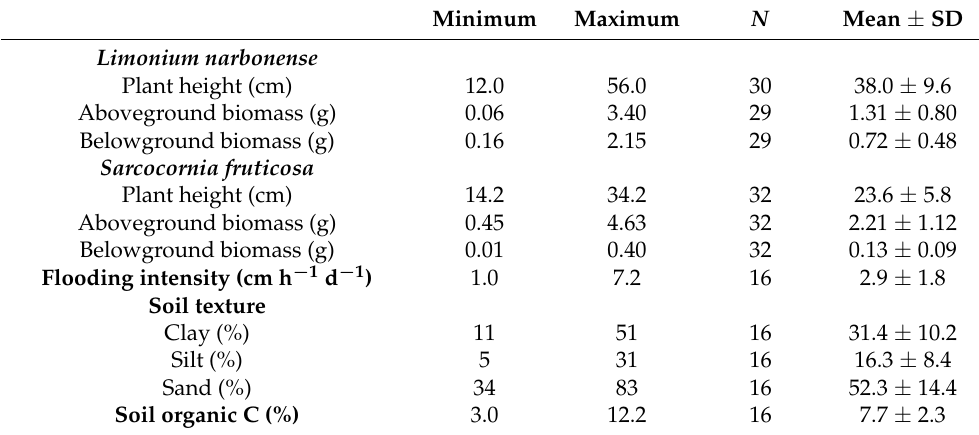
Table 1. Plasticity of plant traits and variability of edaphic factors within the sampling sites. The range (minimum and maximum) and the mean ± standard deviation is reported for plant traits of Limonium narbonense and Sarcocornia fruticosa and for soil texture and organic C content. N refers to the number of